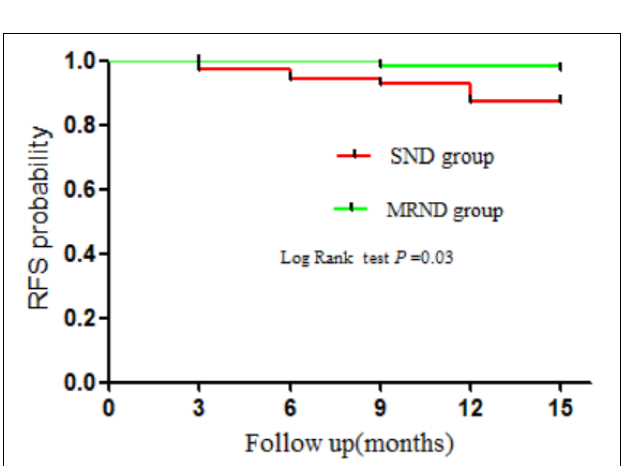
FIGURE 4 | Kaplan-Meier plots of recurrence-free survival (RFS) rates for N1b PTMC patients. SND, selective neck dissection; MRND, modified radical neck